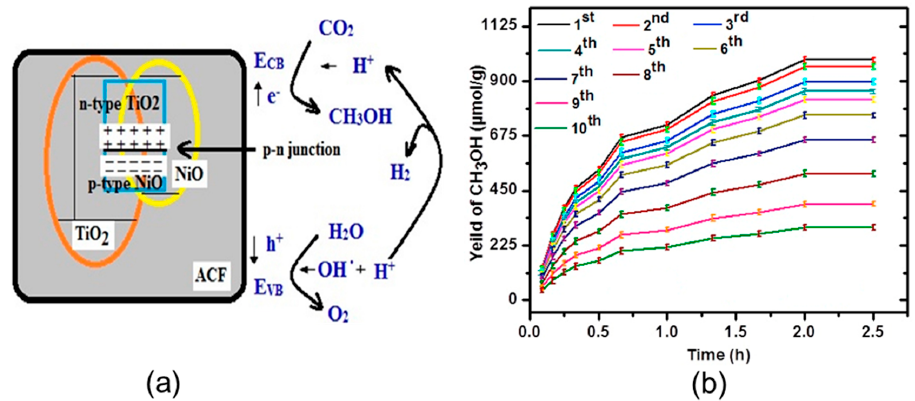
Figure 16. ( a ) The mechanism of photocatalytic reduction of CO 2 into methanol. ( b ) Photocatalytic cycling test of NiO–TiO 2 /ACF under visible light irradiation. Reprinted with permission from [242].